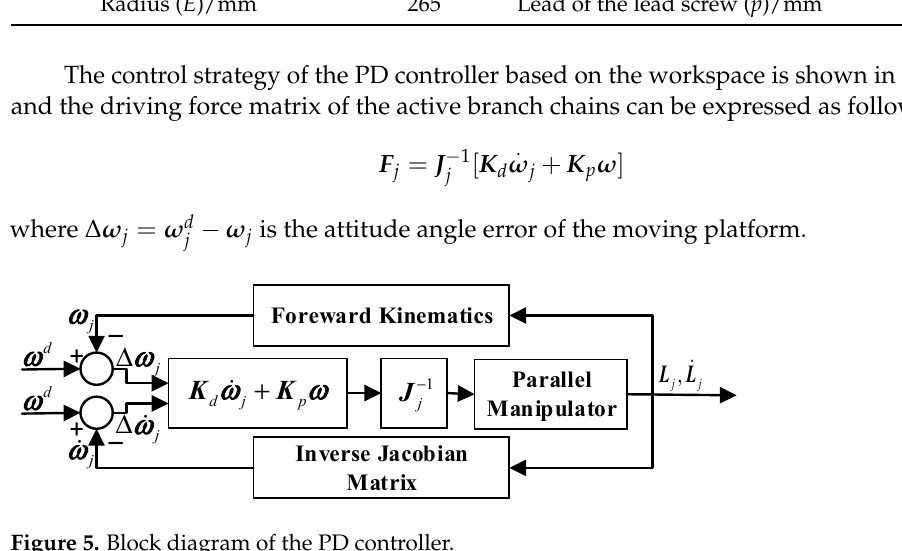
Table 1. Main structure parameters of the parallel manipulator. Parameters Values Parameters Values Length of joint lever ( l l ) /mm 328 Height ( h 1 )/mm 899 Radius ( e )/mm 144 Height ( h 2 )/mm 490 Radius ( E )/mm 265 Lead of the lead screw ( p )/mm 10